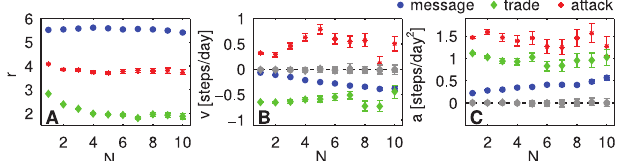
Acceleration in positive direction, i.e. slowing of convergence for messages increases with N message